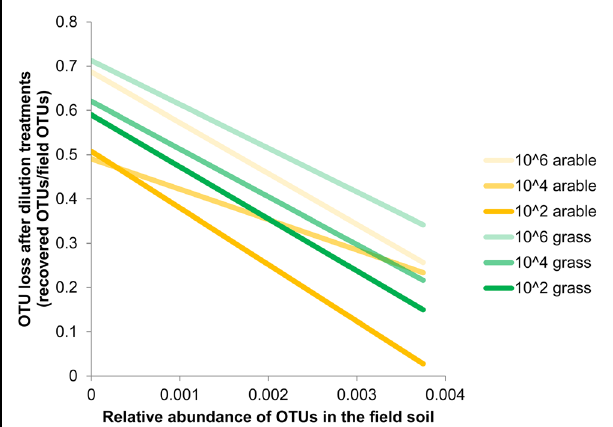
FIGURE 1 | Loss of Operational Taxonomic Units (OTUs) after dilution treatments correlates with abundance of OTUs in the field. Estimated by comparing OTUs detected at the end of the greenhouse experiment with the relative abundance in the pasture and arable field soil. Bacterial OTUs were obtained after 454-pyrosequencing of 16S rRNA gene fragments from field soil ( n = 1) and the soil from the dilution treatments after plant growth ( n = 5 (pasture) or n = 6 (arable) samples with 2000 reads per sample). Relative abundance is the number of reads per OTU/total number of OTUs. Species loss for each relative abundance was calculated as: (the number of field OTUs that were not detected in the greenhouse experiments / total number of field OTUs). Trend lines based on least squares are shown, underlying data is presented in Supplementary Table S2.